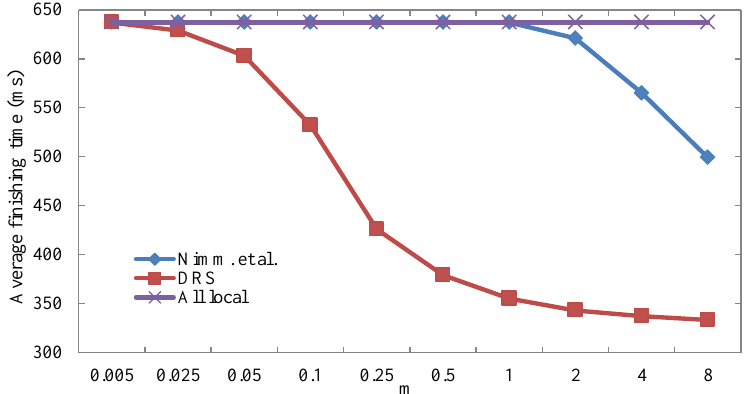
Figure 10 Finishing time for synthesized